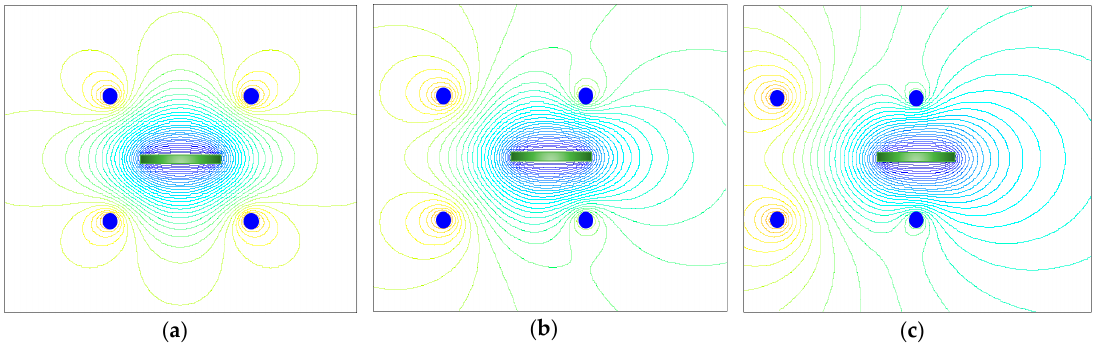
Figure 12. Equipotential line pattern for lateral shifting of the horizontal well. ( (a–c) show the equipotential line pattern of different lateral location.)